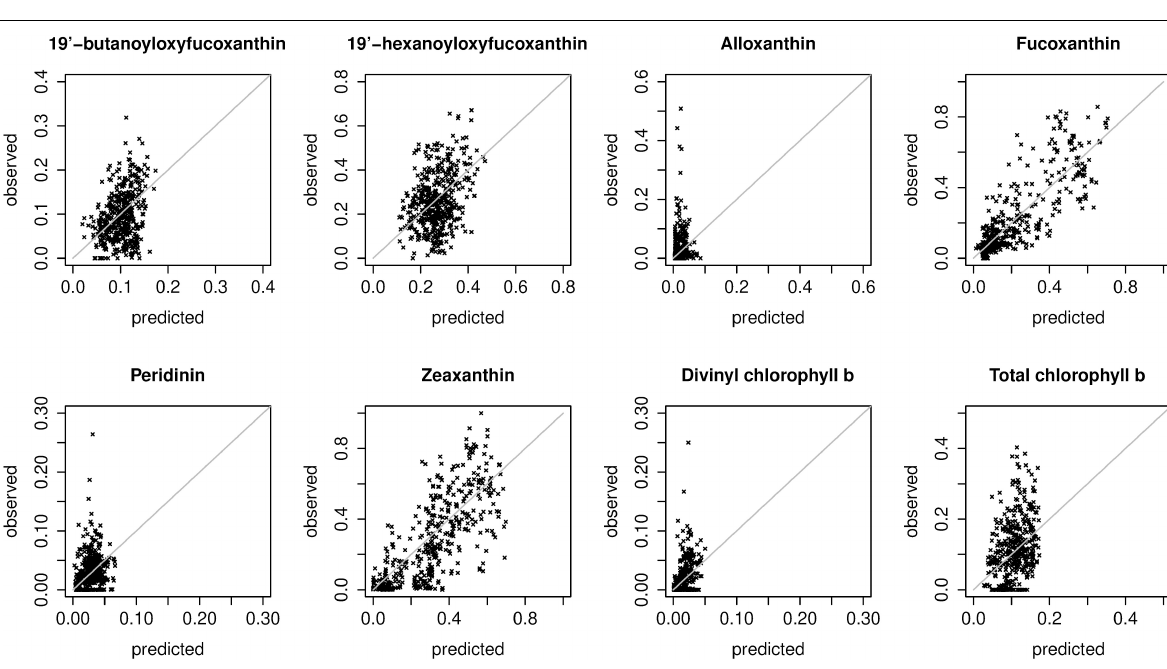
FIGURE 4 | Scatter plots of predicted and observed relative pigment concentrations. Predictions were extracted from the spatial block cross-validation: for each in situ observation, the prediction was made with a model trained on all spatial blocks except the block containing the observation (i.e., the plots show extrapolation errors). The plots show predictions made with the best overall model for each pigment ( Table 2 ). Note that the axis limits differ between